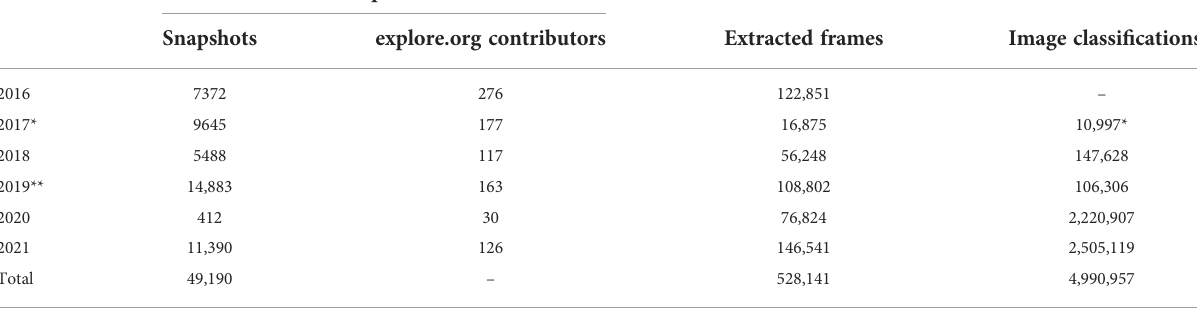
TABLE 1 Summary of fi eld data collection and contributions by citizen scientists.